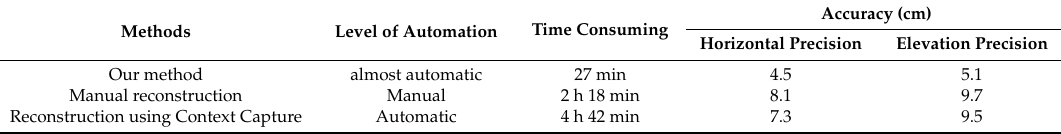
Table 1. Statistics of relevant measures from different reconstruction